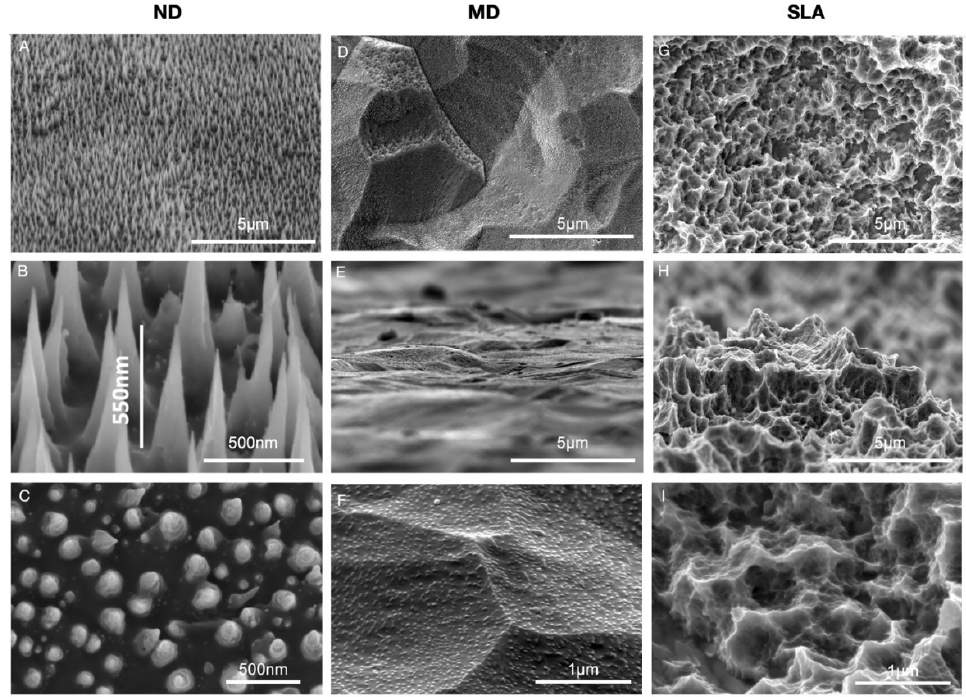
Figure 1. Top-view SEM images of nanostructures of up to 500 nm in height—ND ( A – C ), machined titanium surfaces—MD ( D – F ), and SLA surfaces ( G – I ). Images ( A , B ) show views at a 52° tilt angle; ( E , H ) show views at an 85° tilt angle.